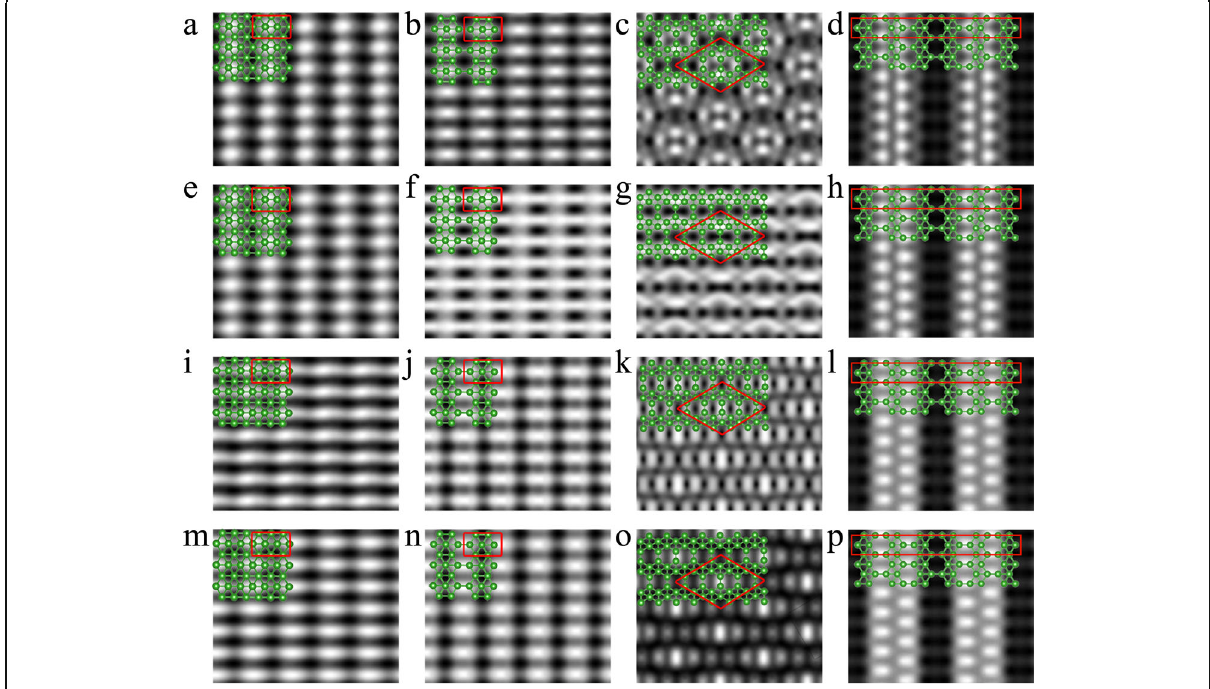
Fig. 6 Simulated STM images for boron sheets on Ag(111). Buckled triangular borophene on Ag(111) at a 0.8, e 0.2, i − 0.4, and m − 1.0 V. β 12 borophene on Ag(111) at b 0.8, f 0.2, j − 0.4, and n − 1.0 V. χ 3 borophene on Ag(111) at c 0.8, g 0.2, k − 0.4, and o − 1.0 V. χ 3 ’ borophene on Ag(111)